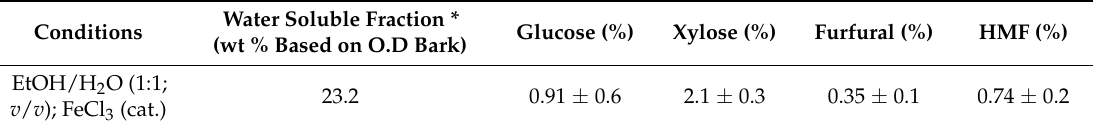
Table 5. Analysis of liquid fraction obtained after removal of precipitated lignin from residual liquor of bark organosolv